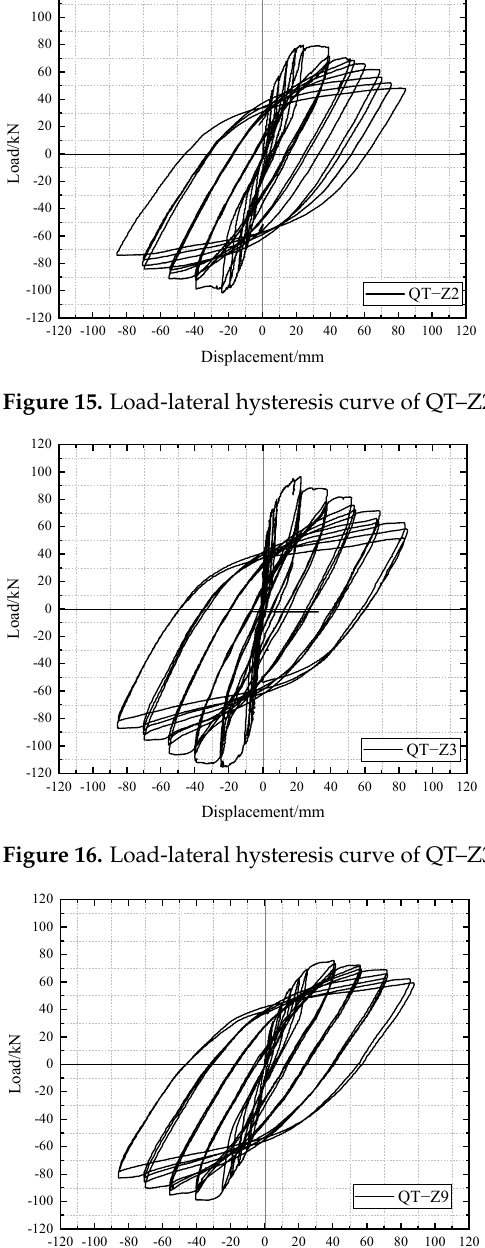
Figure 14. Load-lateral hysteresis curve of QT − Z1.